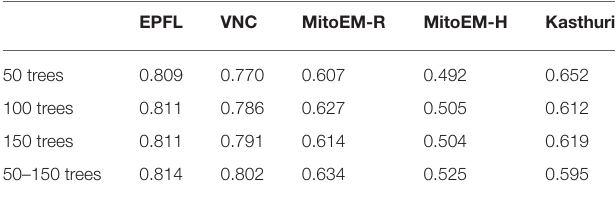
TABLE A2 | F1-scores of the prediction enhancer trained on RF predictions with different numbers of trees for mitochondria